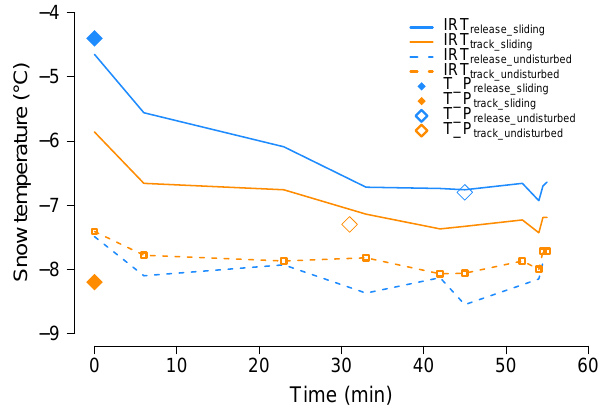
Figure 4. Temporal evolution and comparison of snow temperatures of avalanche #2 using an IRT camera and manually measured data. Solid lines represent IRT measurements in the release (blue line) and track (orange line) sliding surfaces. Dashed lines represent IRT measurements performed in the undisturbed snow cover close to the release (blue) and close to the avalanche path (orange). Small dots on the orange dashed line correspond to the time resolution of all IRT measurements. Data from IRT are compared with manual mea- surements performed at the corresponding layer (filled diamonds) and at the snow surface (empty diamonds) at the closest snow pro-